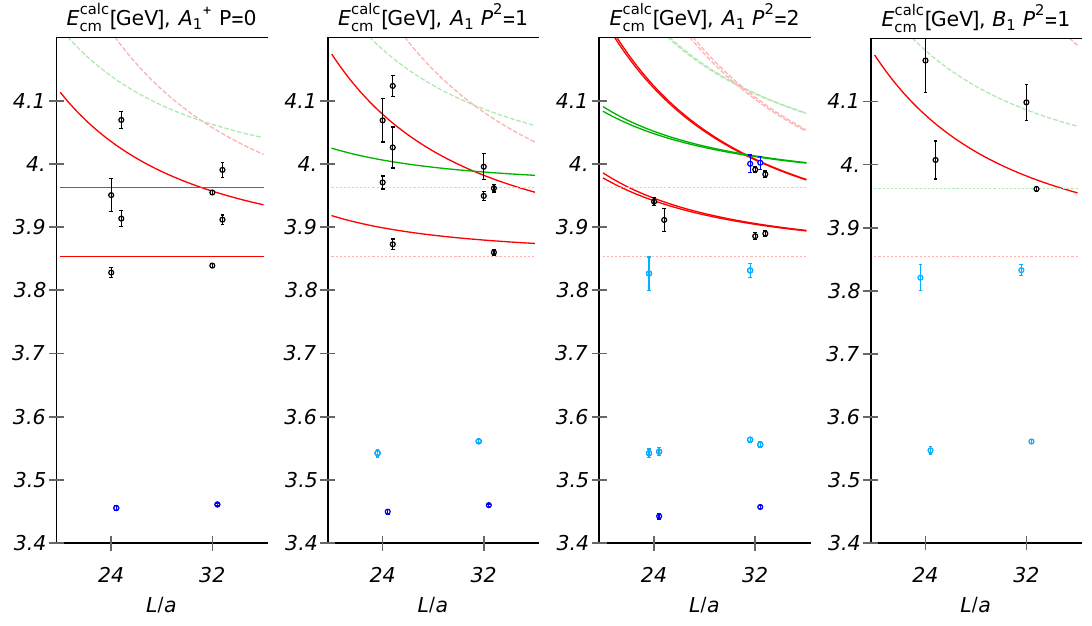
Figure 2 . The eigen-energies in the center-of-momentum frame ( E cm ) for the charmonium-like system with I = 0 and C = +1 . Results are presented for irreducible representations Λ P = A (+) and total momenta | ~P | 2 = 0 , 1 , 2 , which give information on the channels with J PC = 0 ++ , 2 ± + . The data points correspond to the eigen-energies obtained from the lattice simulation: the black circles are used to extract the coupled-channel scattering matrices for D ¯ D − D s ¯ D s , while the blue circles are omitted from the scattering analysis. The solid and dashed red (green) lines correspond to discrete D ¯ D ( D s ¯ D s ) eigen-energies in the non-interacting limit: solid lines correspond to the operators that are implemented, while dashed lines correspond to the lowest-lying energies from operators that are not implemented. Dotted lines represent thresholds. The data points indicated by the light blue circles correspond to ground-state charmonia with J PC = 2 ++ and 2 − + , which appear at m ’ 3 . 56 GeV and 3 . 83 GeV, respectively. Some points are shifted horizontally slightly for